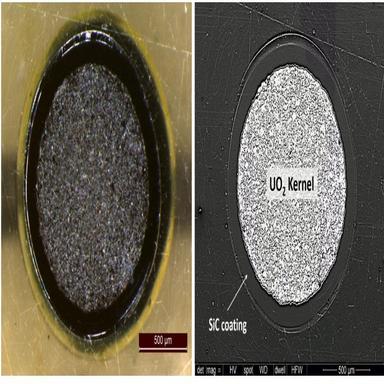
Images of coated fuel microsphere slice obtained by Leica M165 optical microscope.